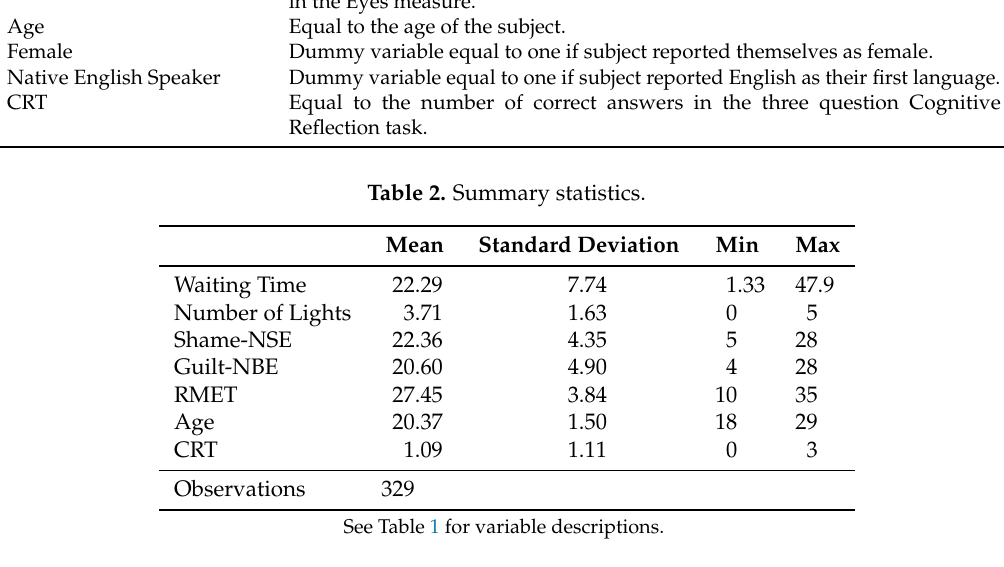
Table 3. Correlation